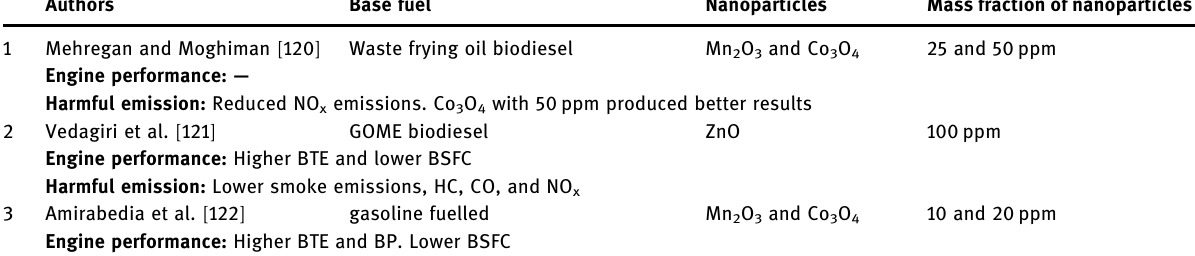
Table 5: Summary of other metal oxides nanoparticles as an additive in diesel/biodiesel fuel Authors Base fuel Nanoparticles Mass fraction of